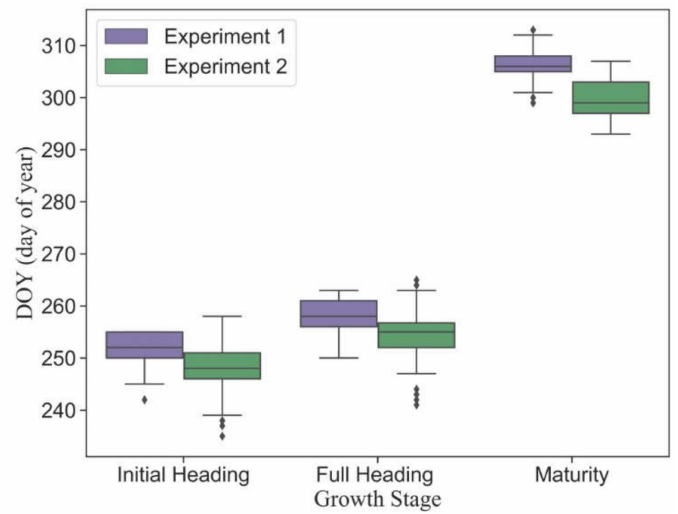
Figure 4. The statistical distribution of the main observed phenology in Experiment 1 (late-maturity cultivars) and Experiment 2 (early-medium-maturity cultivars).